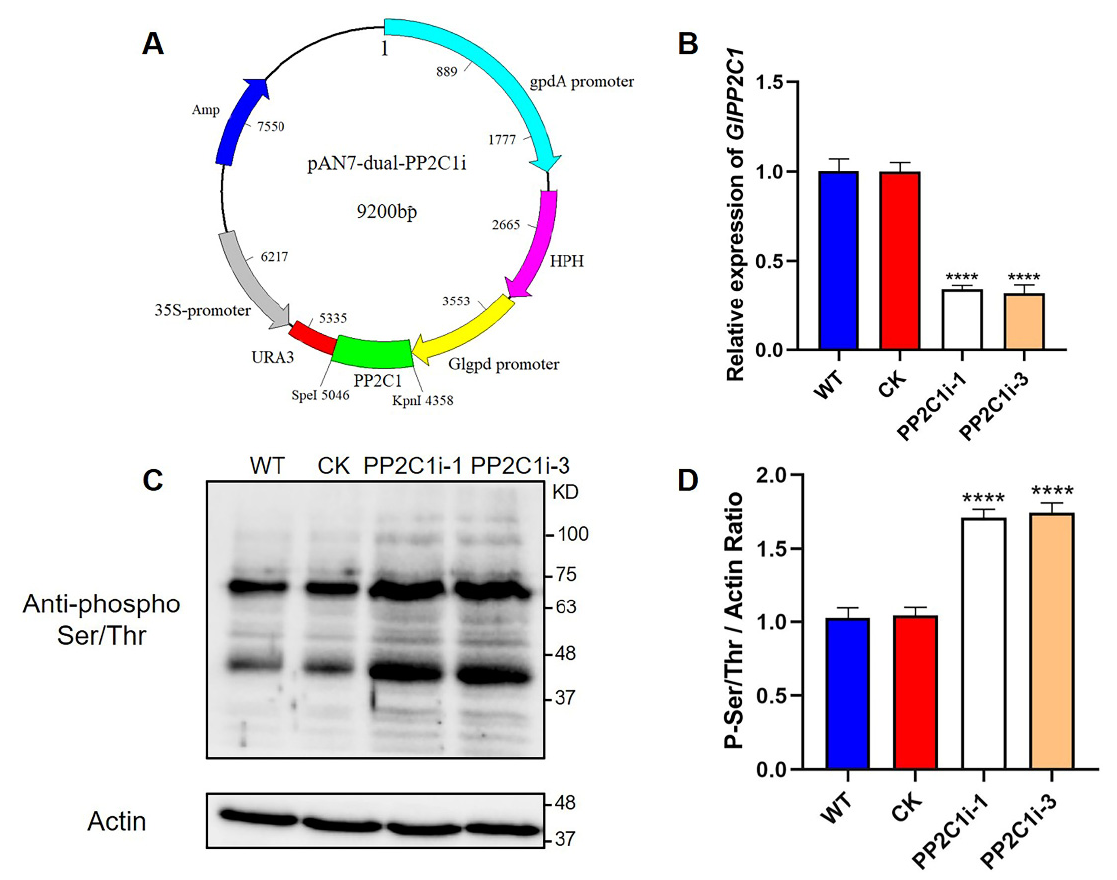
Figure 1. Detection of the GlPP2C1 transcript levels and the phosphorylation of Ser/Thr in PP2C- silenced strains. ( A ) Plasmid map of the PP2C silenced gene. ( B ) qRT–PCR analysis of the expression of GlPP2C1 in the tested strains. ( C ) Western blotting analysis of the effectiveness of PP2C-silenced strains with phospho-Ser/Thr antibodies. The actin protein level was used as a loading control. ( D ) The relative intensity of the two prominent phospho-Ser/Thr bands was determined using ImageJ software. The data are presented as the means ± standard deviations (SDs) from three independent experiments (**** p < 0.0001 by one-way